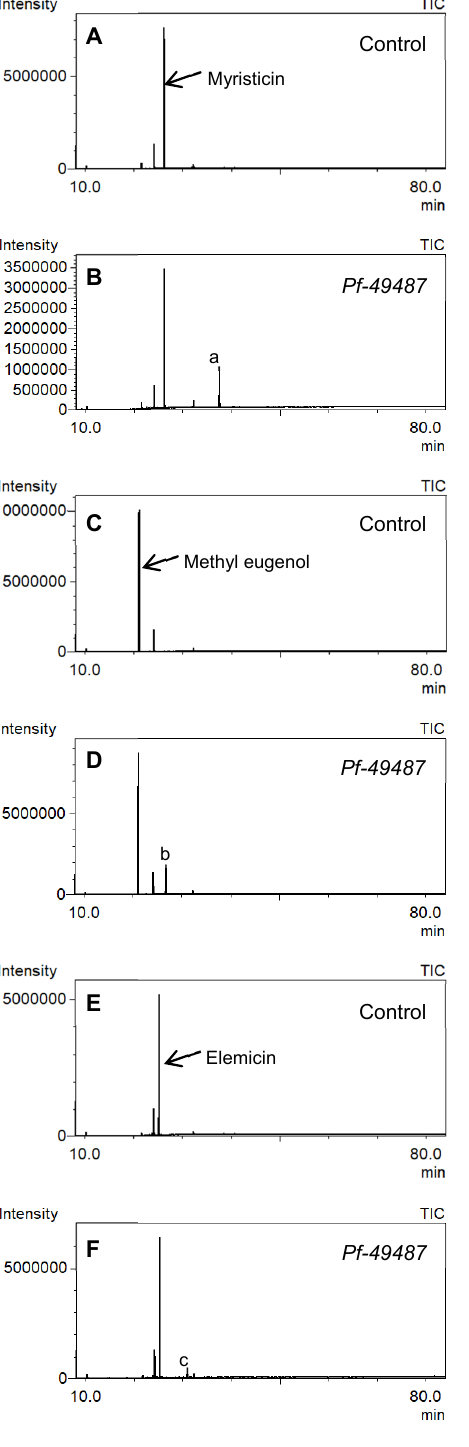
Figure 6. Gas chromatography-mass spectrometry (GC-MS) profiles of the reaction products. ( A – F ), Total ion chromatograms of the products obtained using the control ( A , C , E ) and the microsomal fraction prepared from yeast harboring Pf-49487 ( B , D , F ). The substrates are myristicin ( A , B ), methyl eugenol ( C , D ), and elemicin ( E , F ). The controls were incubated without the cofactor NADPH. The peak with a retention time of 24 min is the internal standard, eugenol. ( G – I ), Mass spectra of the products formed by Pf-49487 with myristicin, methyl eugenol, and elemicine as the substrates, respectively.